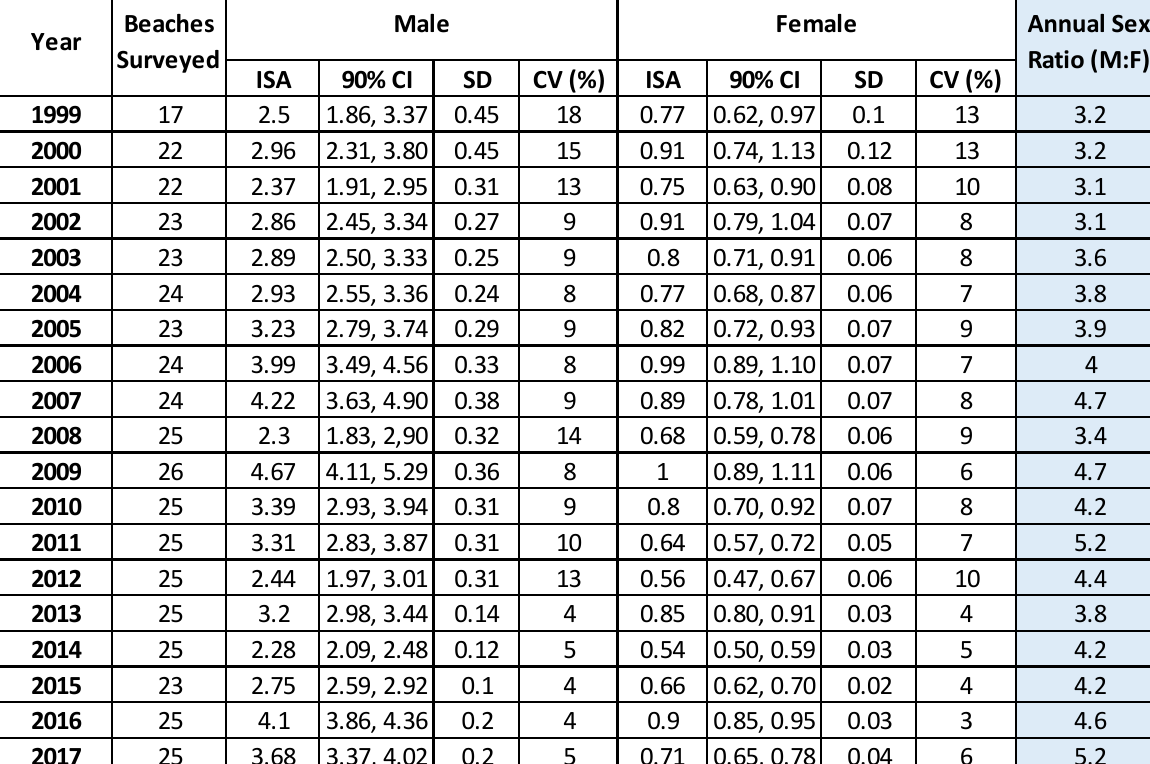
Table 35. Indices of bay-wide male and female horseshoe crab spawning activity (ISA), number of beaches surveyed, standard deviation (SD), coefficient of variations (CV), 90% confidence intervals (CI) and sex ratio for the Delaware Bay from 1999 to 2017 (Source: DE